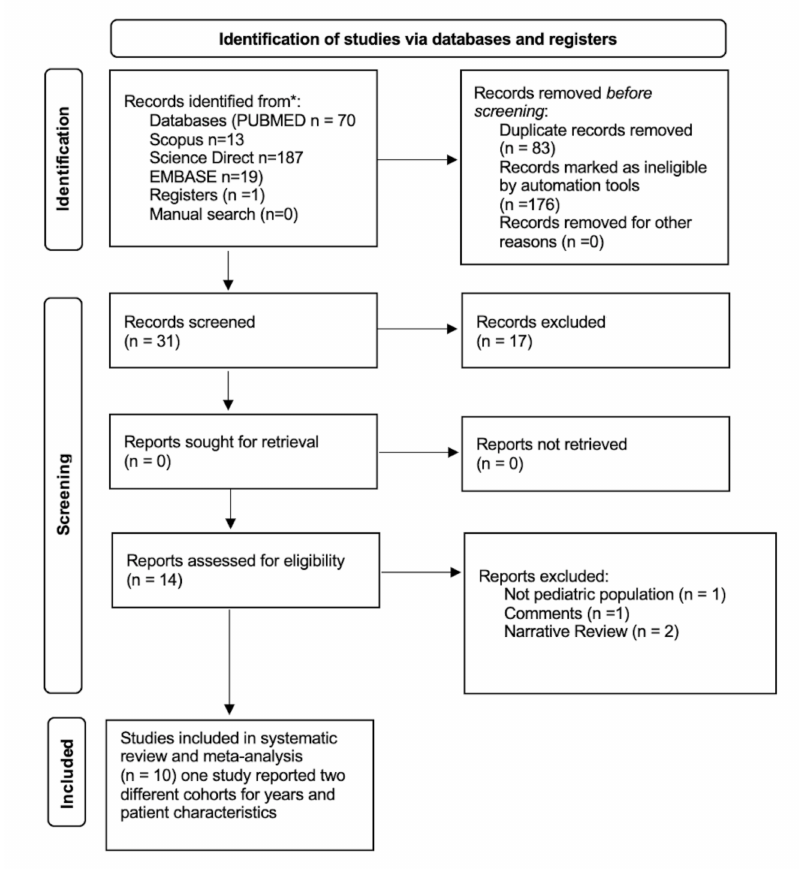
Figure 1. PRISMA